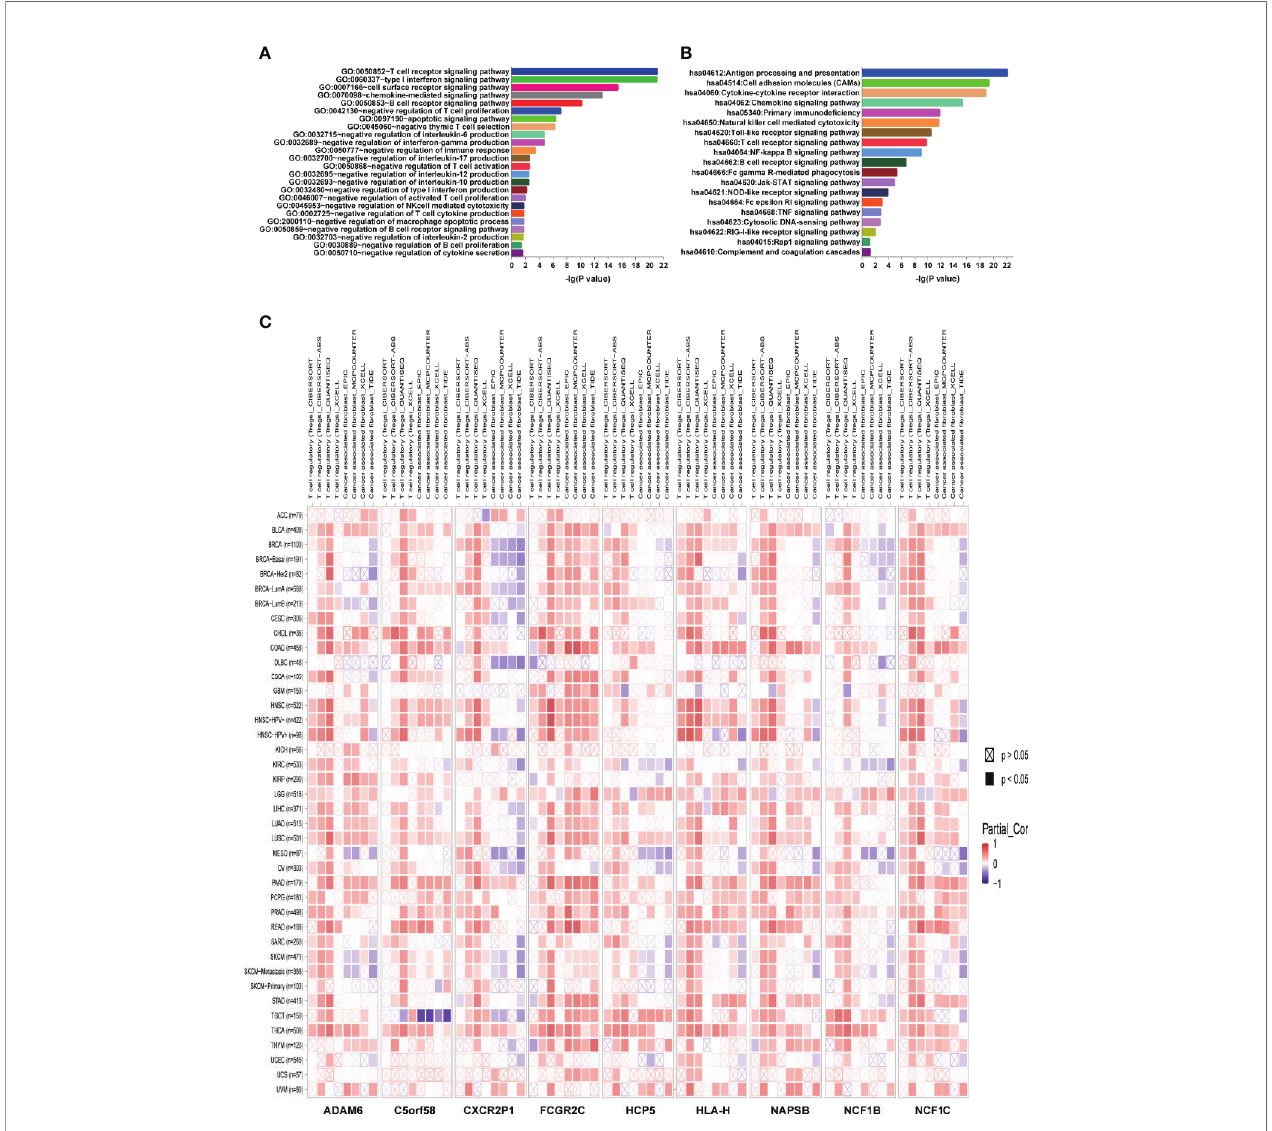
FIGURE 7 | ICLs play vital roles in the negative regulation of the immune response. (A) Geneontology term enrichment analysis for ICL-related biological processes. (B) Kyoto Encyclopedia of Genes and Genomes pathway analysis for ICL-related pathways. (C) Expression of nine ICLs and T cell regulatory/cancer-associated fi broblast in fi ltration in 33 human cancer